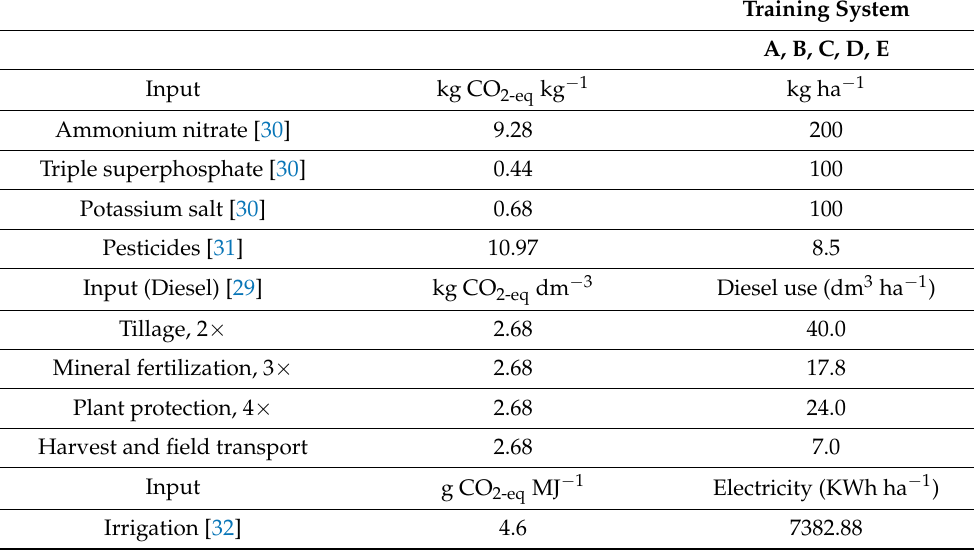
Table 5. Input data for annual